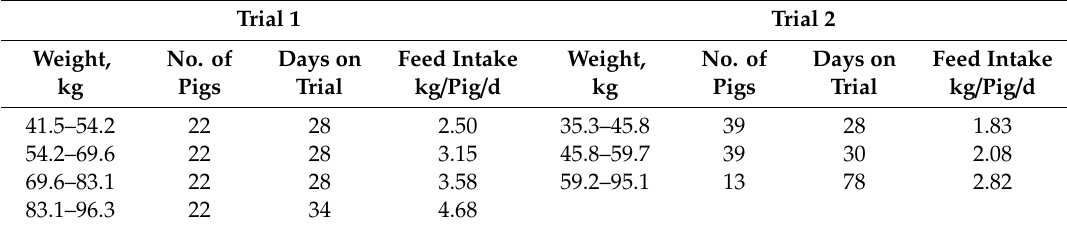
Table A1. Data on Alentejana breed used for modelling [10] 1 .